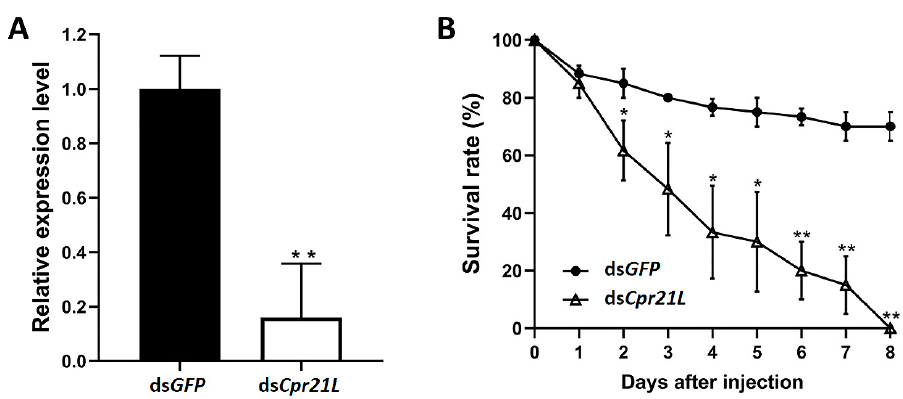
Figure 4. The effects of RNAi against Cpr21L in the BPH. ( A ) The mRNA level of Cpr21L in the 5th instar nymphs after being injected with ds Cpr21L . ds GFP was used as the control, and RPS11 was used as the reference gene to normalize gene expression. ( B ) The survival of nymphs treated with ds Cpr21L . ds GFP served as a control; n = 40 insects. Values are expressed as the mean ± SEM of at least three independent biological replicates. The Student’s t ‐ test was used to compare two groups of samples at the same time point. (* p < 0.05; ** p < 0.01).